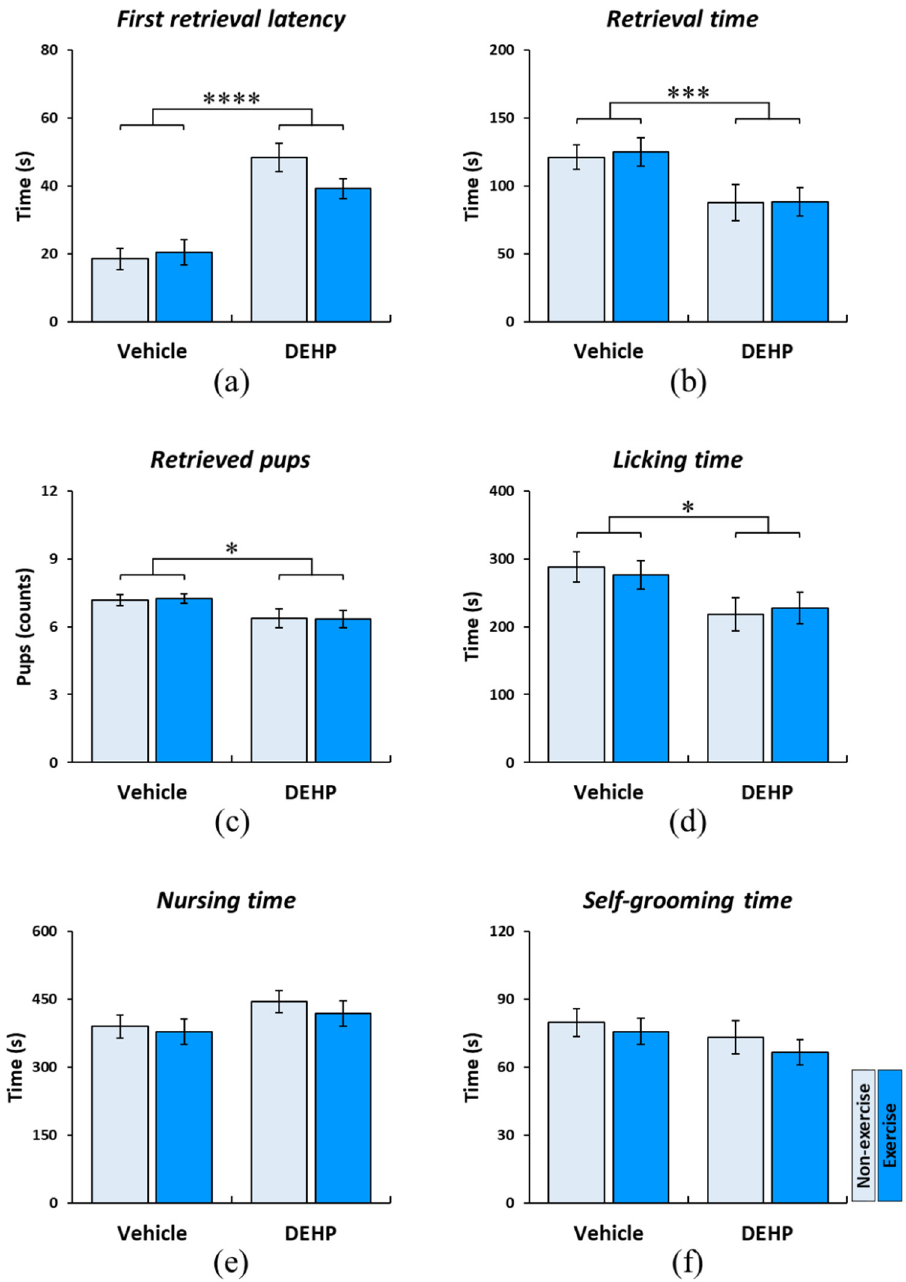
Figure 1. Effects of prenatal DEHP exposure and childhood exercise on maternal behaviors in postpartum dams. The pup retrieval test was performed postpartum, and the mean values of each responsive behavior were shown. There was a significant effect of DEHP on the first retrieval latency ( a ), the total retrieval time ( b ), the total number of retrieved pups ( c ), and the total licking time ( d ). No significant effects of DEHP and exercise on the total nursing time ( e ), and the total self-grooming time ( f ) were found in the present study. Data are presented in mean ± SEM ( n = 12 in each group). *: p < 0.05; ***: p < 0.005; ****: p < 0.001.